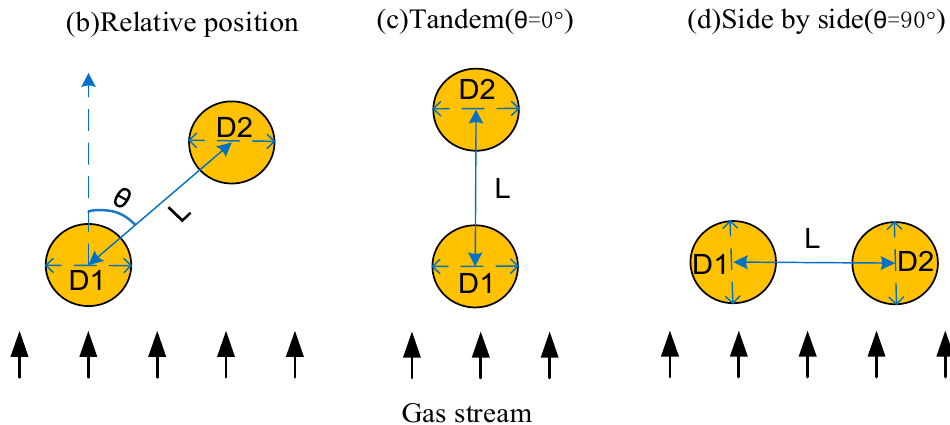
Figure 1. Droplets in annular flow and their relative positions.